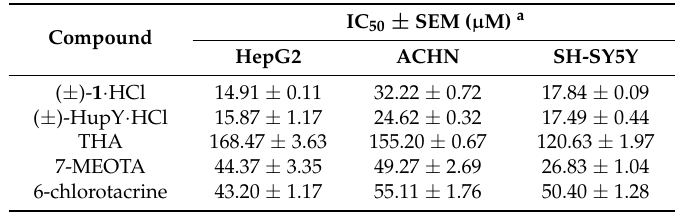
Table 4. Results of cytotoxicity of ( ± )- 1 · HCl and reference compounds in HepG2, ACHN, and SH-SY5Y cell